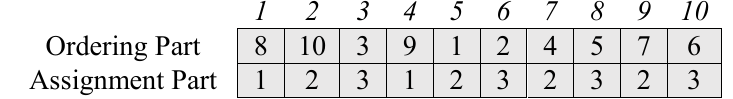
Fig. 2. Representation of a feasible solution for a dataset with 10 jobs and 3 machines